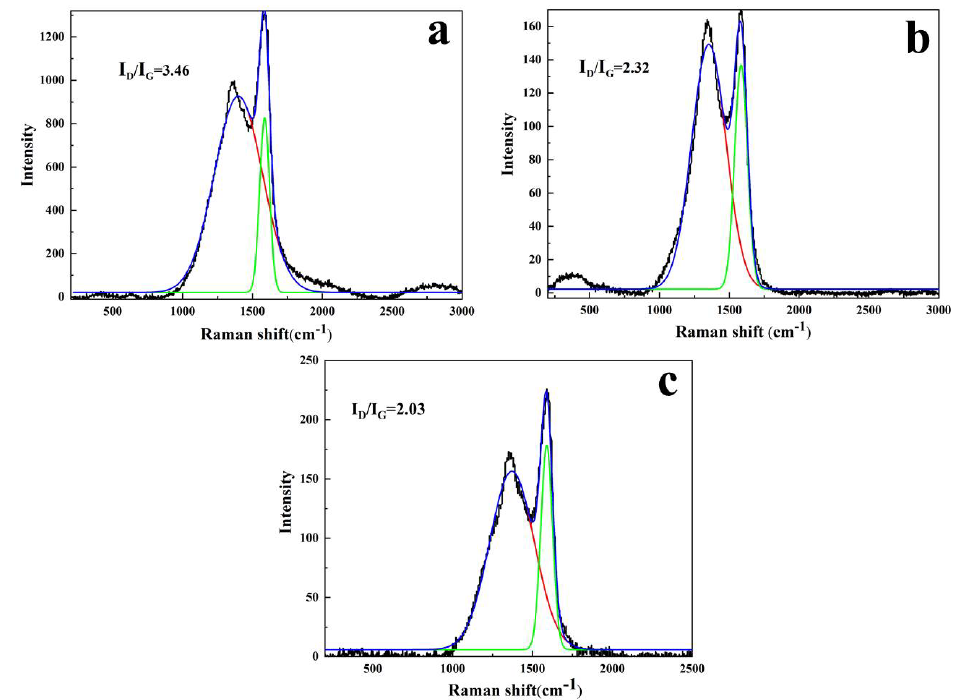
Figure 5. Raman images of ( a ) EP, ( b ) LDHs-1/EP and ( c ) LDHs-2/EP combustion